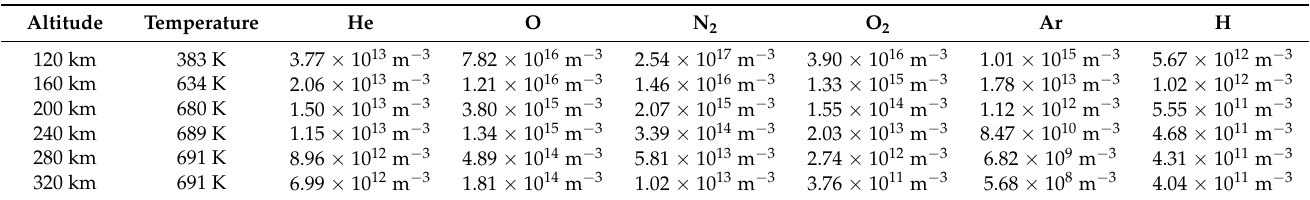
Table 4. Background atmospheric temperature and numerical density of various molecules at different altitudes under low F10.7 and low Ap environments